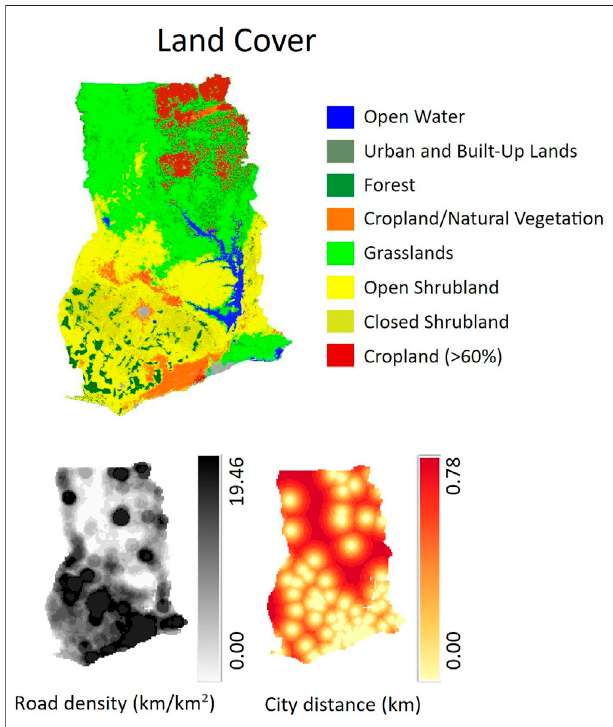
TABLE1| Thecomprehensiveremotesensing,environmental,andsocio-economicdatasetsusedinthisstudy.[1] (cid:1) Hersbachetal.,2021;[2] (cid:1) SchaafandWang,2021;[3] (cid:1) Sahel and West Africa Club, 2020; [4] (cid:1) Didan, 2021; [5] (cid:1) Townshend, 2016; [6] (cid:1) Wan et al., 2015; [7] (cid:1) Earth Observation Group Payne Institute for Public Policy Colorado School of Mines, 2011; [8] (cid:1) Linard et al., 2021; [9] (cid:1) Running et al., 2021 [10] (cid:1) OpenStreetMap contributors, 2017. Variable Temporal Air